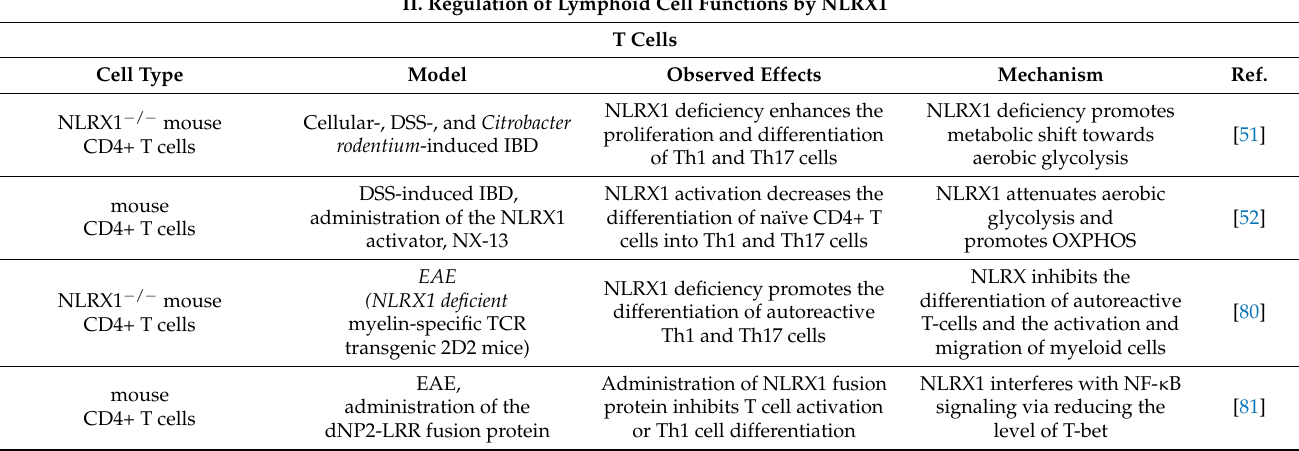
Table 2. Regulation of lymphoid cell functions by